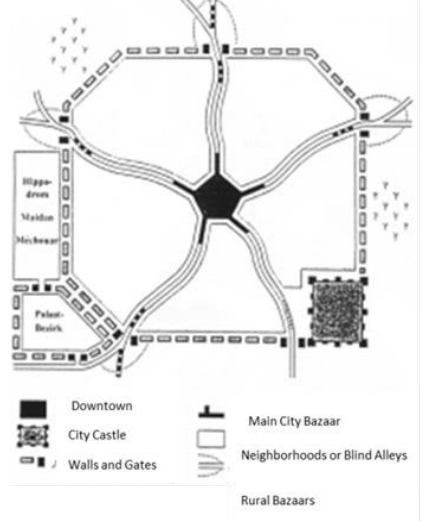
Figure 2 .Islamic City Model (Source: Wirth 2000, Cited by Shafaqi